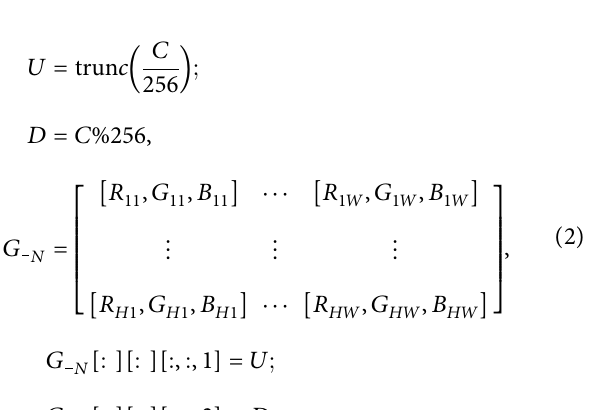
Figure 1: Design of the